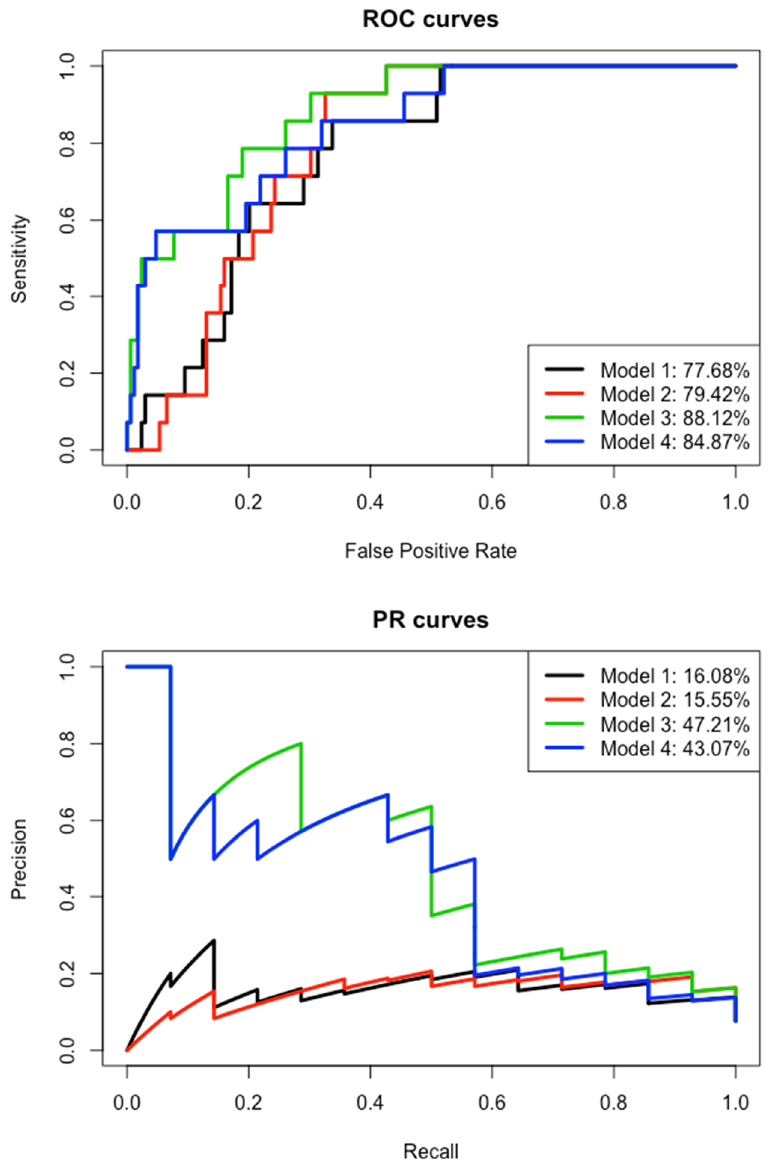
Figure 6. Receiver operating characteristic (ROC) curves and precision–recall (PR) curves of the four models.